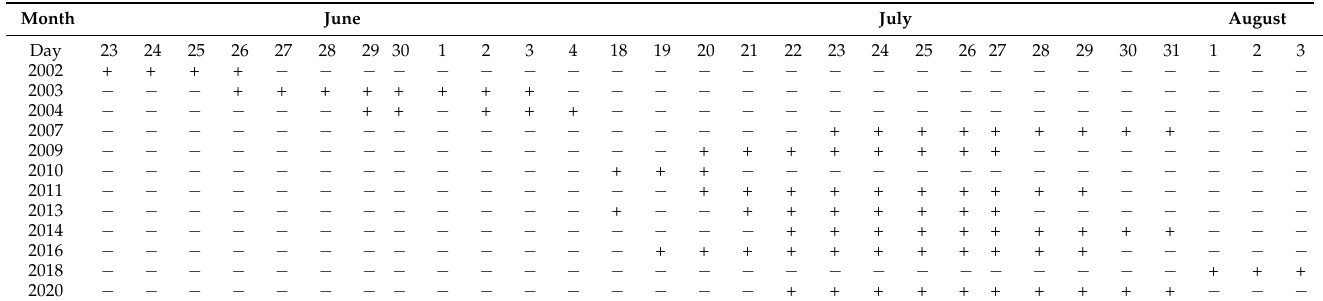
Table 2. Processed data of the field campaigns. “+” denotes the days for which the data have been processed; “ − ” denotes the days for which the data have not been processed